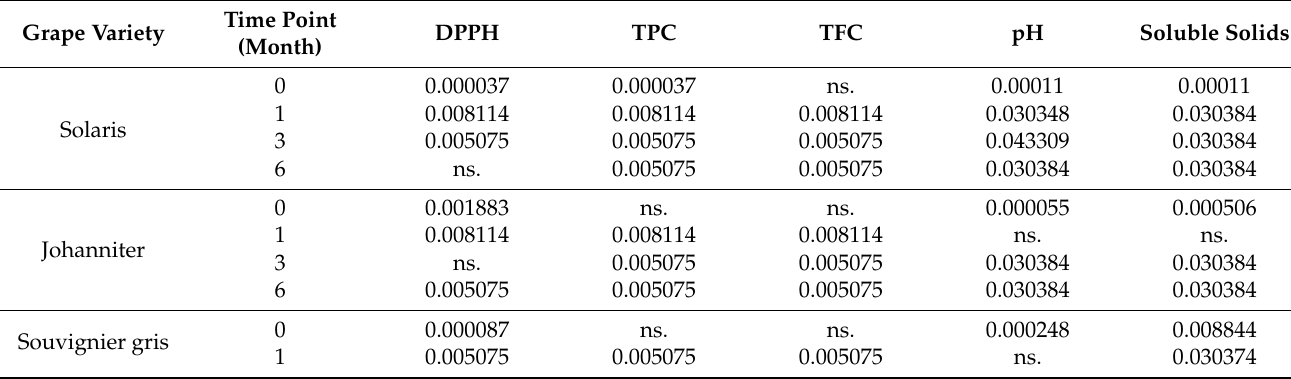
Table 4. The p -values of the Kruskal–Wallis test for samples made with (variant B) vs. without added sugar (variant A) during storage under refrigerated